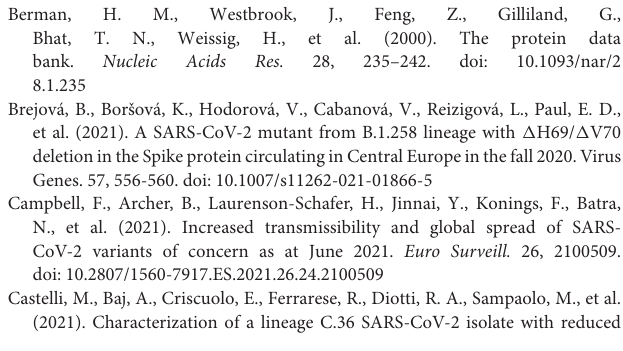
Supplementary Figure 1 | Primers used to amplify S gene. S gene regions were amplified with the following indicated primers: SC2M1-55, SC2M1-56, SC2M1-57, SC2M1-58, SC2M1-59, SC2M1-60, SC2M1-61, and SC2M1-62b. SP, signal peptide; RBD, receptor-binding domain; FP, fusion peptide; HR1, heptad repeat domain 1; HR2, heptad repeat domain 2; TA, Transmembrane association domain; IT, intracellular terminal. Adapted from “An In-depth Look into the Structure of the SARS-CoV2 Spike Glycoprotein” by BioRender.com (2022). Retrieved from https://app.biorender.com/biorender-templates. Supplementary Figure 2 | Non-synonymous substitutions identified in SARS-CoV-2 genomes. The graph shows the number of non-synonymous substitutions among the genes of SARS-CoV-2 identified by NGS. Blue bars show the absolute number of substitutions/gene. Gray bars show the substitutions that have occurred in at least two isolates. ORF, open reading frame; S, Spike; E, envelope; M, membrane; N, nucleocapsid. Supplementary Figure 3 | Mutations in Gamma and C.36.3 isolates. Substitutions identified in the Gamma and C.36.3 isolates by NGS. Black, substitutions common to all Gamma isolates (A) and C.36.3 isolates (B) . ORF, open reading frame; S, Spike; E, envelope; M, membrane; N,